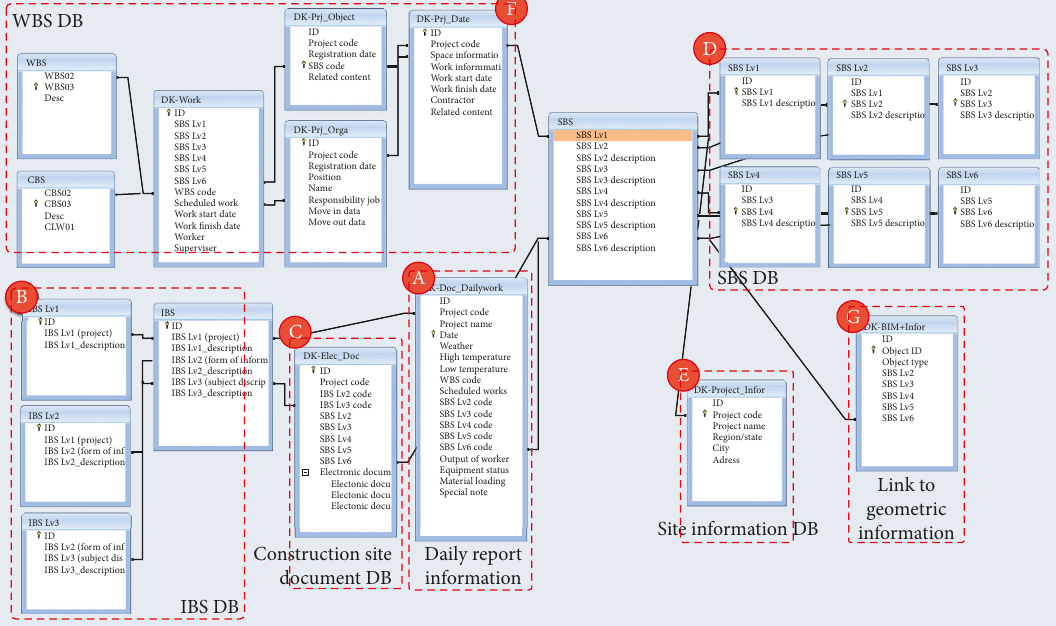
Figure 8: Connection relationships of the construction information